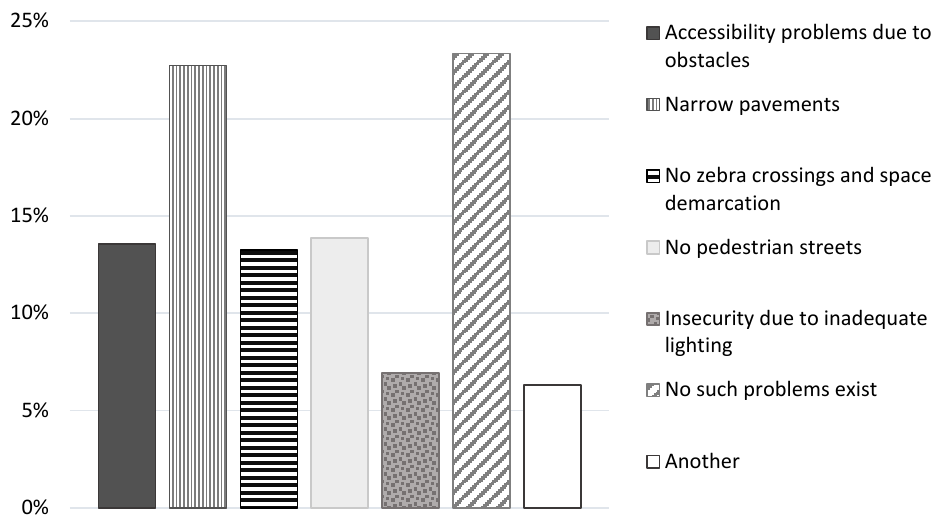
Figure 12. Pedestrian problems in the RMSC.